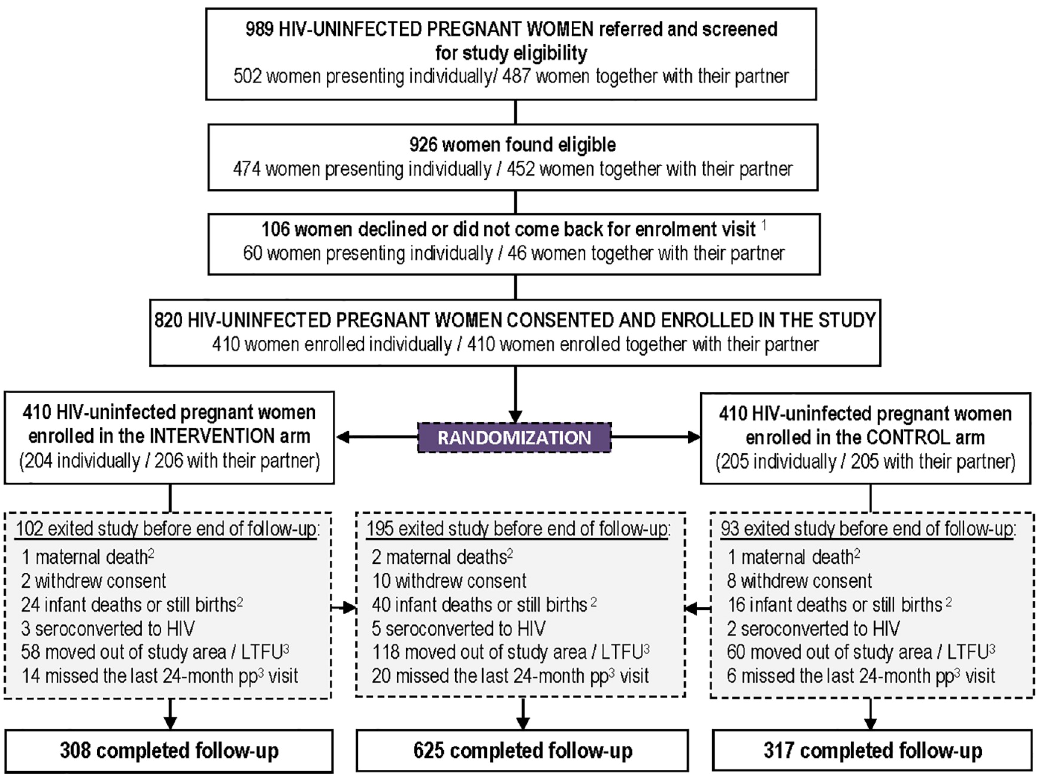
Fig 1. Trial profile. 1 None of these women presented with any particular risk profile according to their screening data; 2 Unrelated to the intervention 3 LTFU: lost to follow-up.